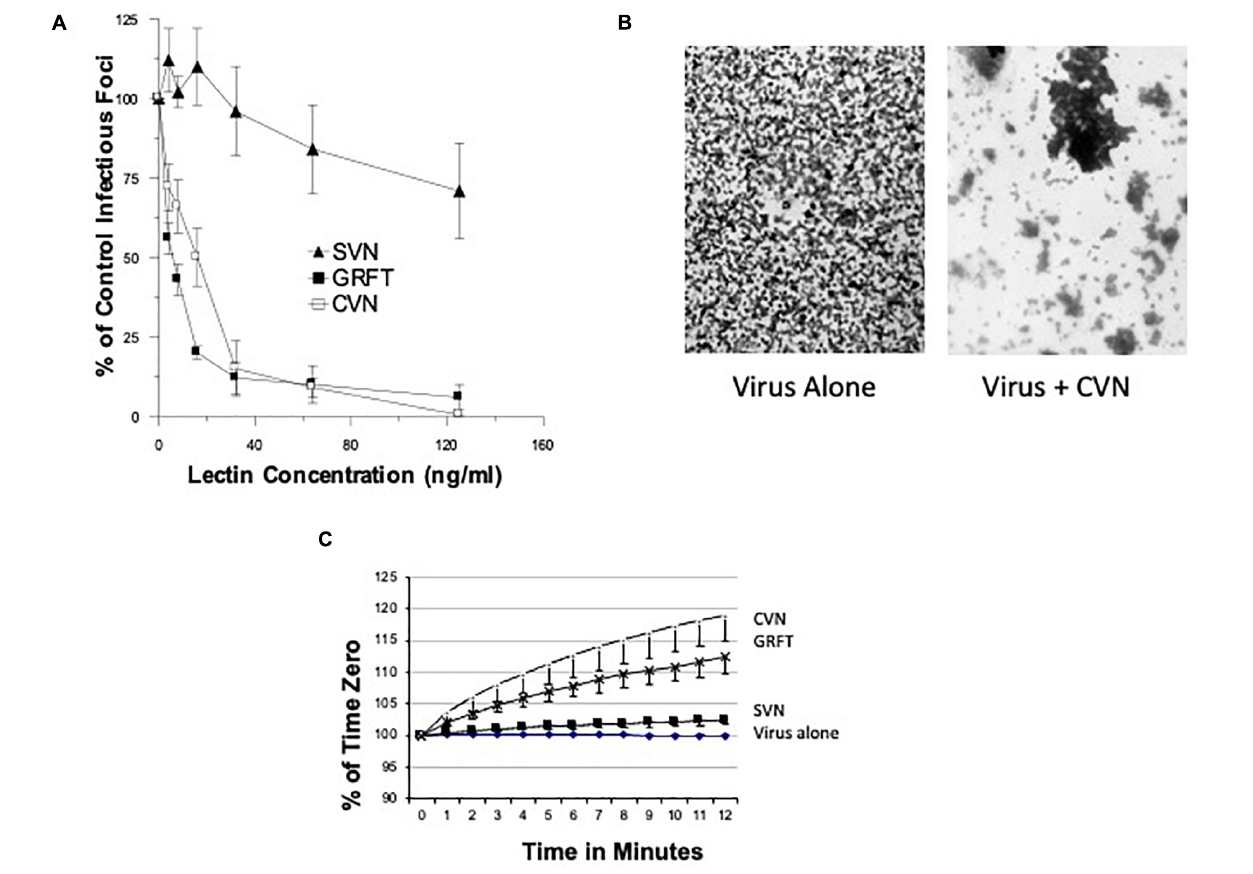
FIGURE 7 | Evaluation of neutralizing activity and viral aggregating activity of cyanovirin, griffithsin, or scytovirin. (A) Neutralizing activity of the indicated collectins (cyanovirin = CVN, griffithsin = GRFT, and scytovirin = SVN) was tested vs. the Phil82 strain of IAV (mean ± SEM; n = 5). (B) The ability of cyanovirin to aggregate this viral strain was assessed by electron microscopy (representative experiments of three). Aggregation by the three lectins was tested also by light transmission in (C) (mean ± SEM; n =